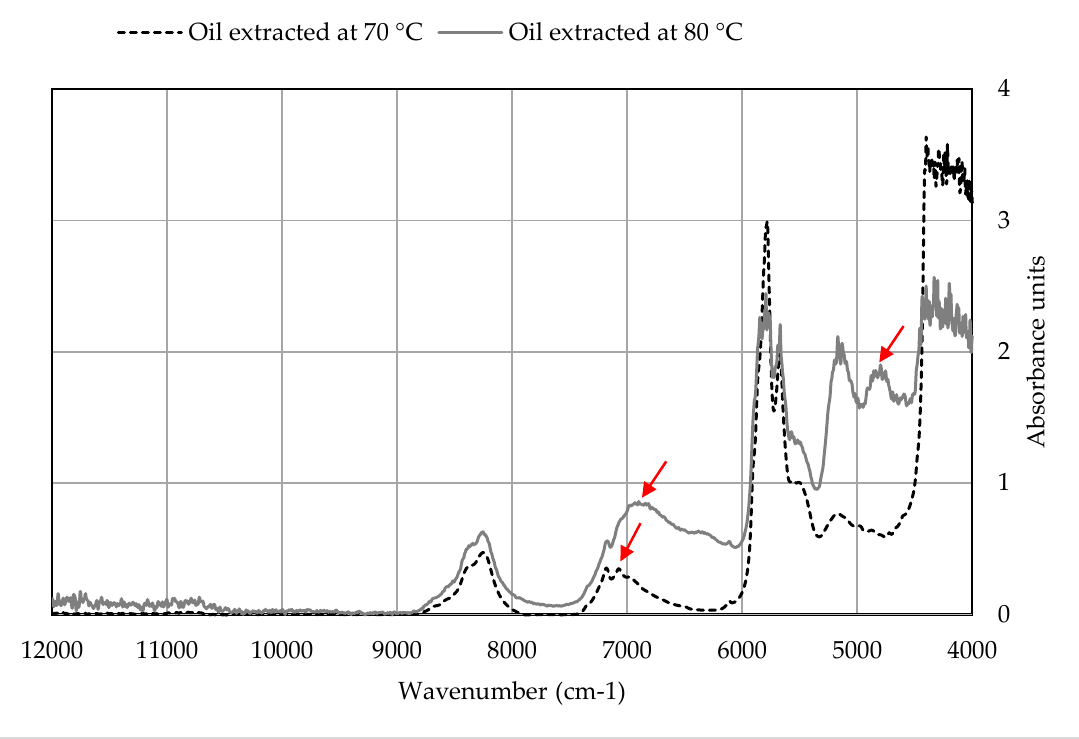
Figure 3. The NIR spectra of the extracted oil. 402 Figure 5. The NIR spectra of the extracted oil. The red arrows indicate the spectral shift between the oil extracted at 70 ◦ C and the one extracted at 80 ◦